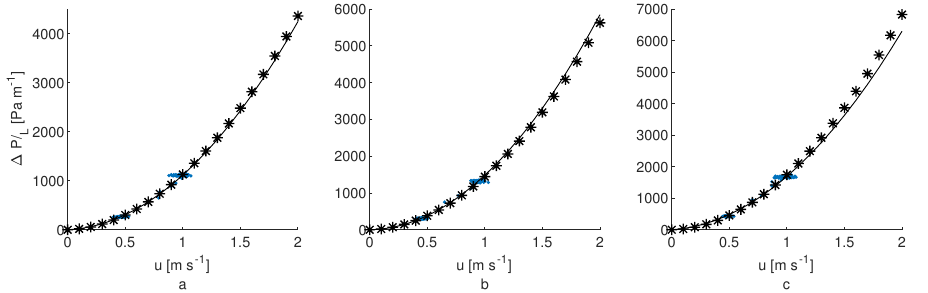
Figure 13. Comparison of the BC pad experimental pressure drop (blue point) computed with the Darcy–Forchheimer Equation (5) considering the permeability and Forchheimer as a constant and the equation fitted for each water flow (black solid line) and considering the permeability constant and the Forchheimer coefficient as a function of the water flow (asterisk markers). ( a ) Water flow of